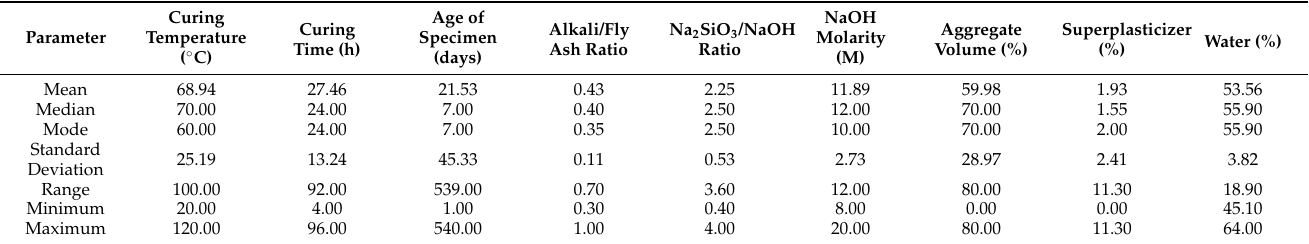
Table 1. Results of the descriptive statistical analysis of input